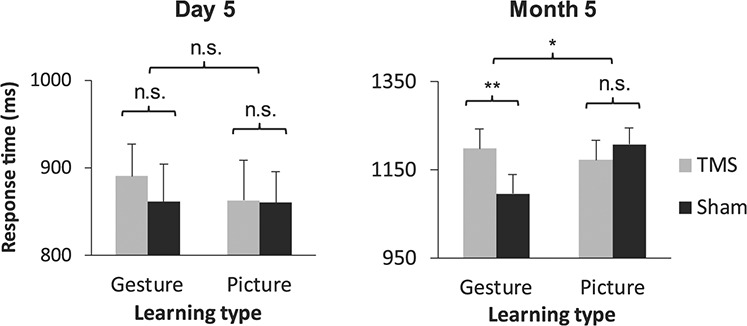
Effects of bmSTS stimulation on speed of L2 translation by time point. Effects of bmSTS stimulation on response times in the multiple-choice task occurred 5 months following learning (n = 22 participants). Error bars represent one standard error of the mean. *P < 0.05, **P < 0.01.